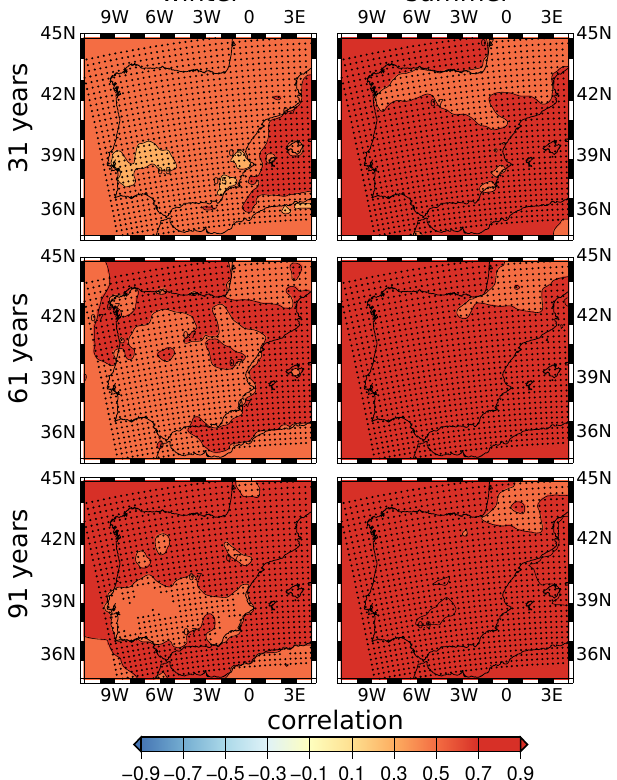
Fig. 2. Correlation map of SAT series in winter (December– February, left column) and summer (June–August, right column) between the MM5-ERIK1 and MM5-ERIK2 experiments. The three rows represent the correlations calculated with the series smoothed by a running mean filter of 31 (top), 61 (middle) and 91 (bottom) years, respectively. Black circles denote grid points where the correlation is significant at the 95% confidence level according to a bootstrap method (Ebisuzaki,